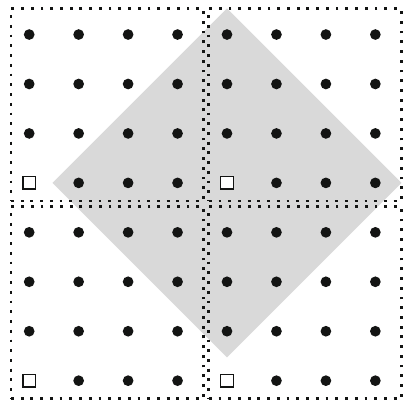
M 2 n , m corresponding to ( x / a ) = ( 4 , 4 ) has non-zero entries only in the shaded region where the probing vector is zero. Right: as on the left but for smaller blocks labeled even and